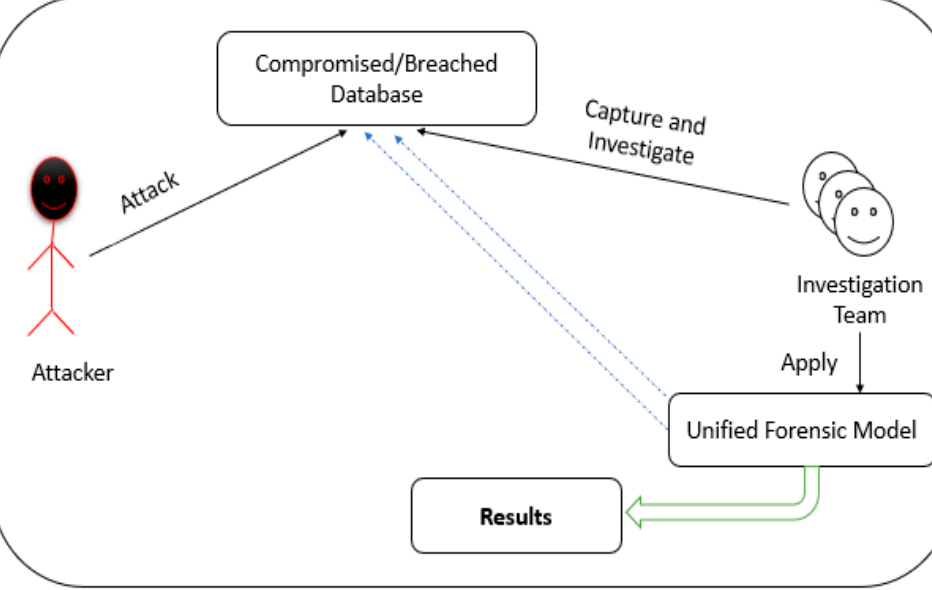
Figure 11. Experiments environment.